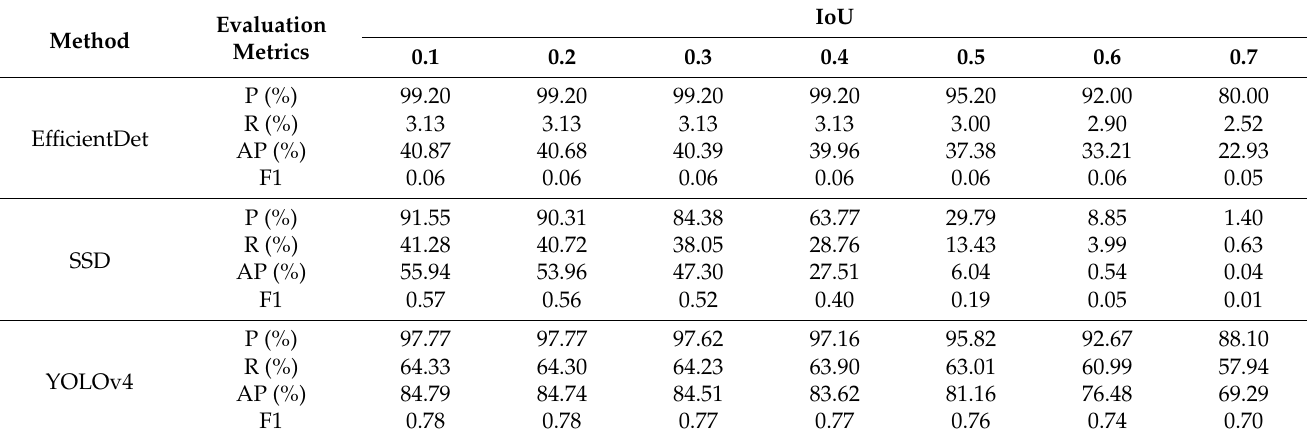
Table 5. Performance evaluation results of each method with different IoU